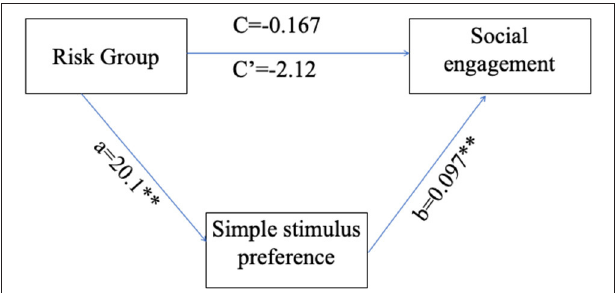
FIGURE 6 | Simple stimulus preference as a mediator for the relations between risk group and low/high social stimulus engagement ratio. a, the path coefficient for the effect of risk group on simple stimulus preference; b, the path coefficient for the effect of simple stimulus preference on social engagement; c, the path coefficient for the direct effect of risk group on social engagement; c’, the path coefficient for the total effect of risk group on social engagement. ** p <